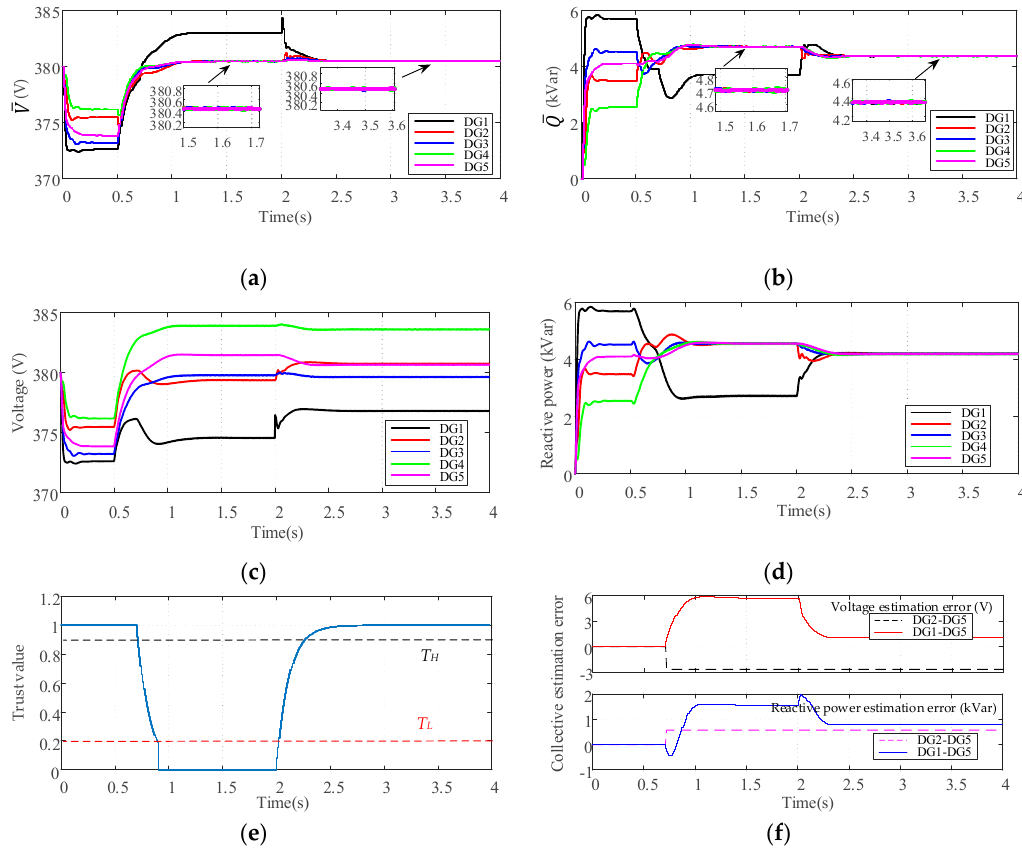
Figure 9. Performance of the control scheme only with the discarding information mechanism: ( a ) Average voltage estimates; ( b ) Average reactive power estimates; ( c ) Voltages of DGs; ( d ) Reactive power of DGs. ( e ) Common trust value of DG1; ( f ) Collective estimation error.